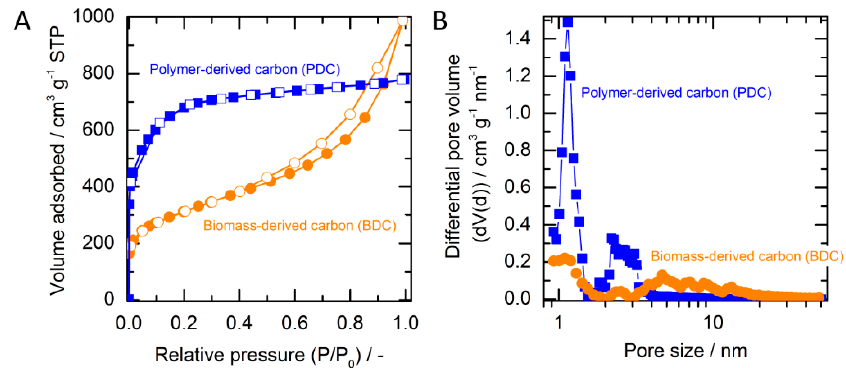
Figure 1. ( A ) N 2 -sorption isotherm (closed symbol: adsorption, open symbol: desorption). ( B ) Pore size distribution of carbon produced from biomass and synthetic carbon precursors.